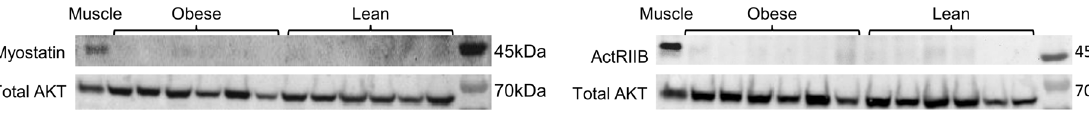
Figure 5. Protein expression of Myostatin precursor and ActRIIB proteins in crest fat of lean and obese horses and ponies. Protein expression of myostatin precursor protein and ActRIIB was assessed by Western blot with total AKT used as a loading control. Blots are shown for crest fat expression across all animals with a skeletal muscle sample used as positive control. n=6/group.